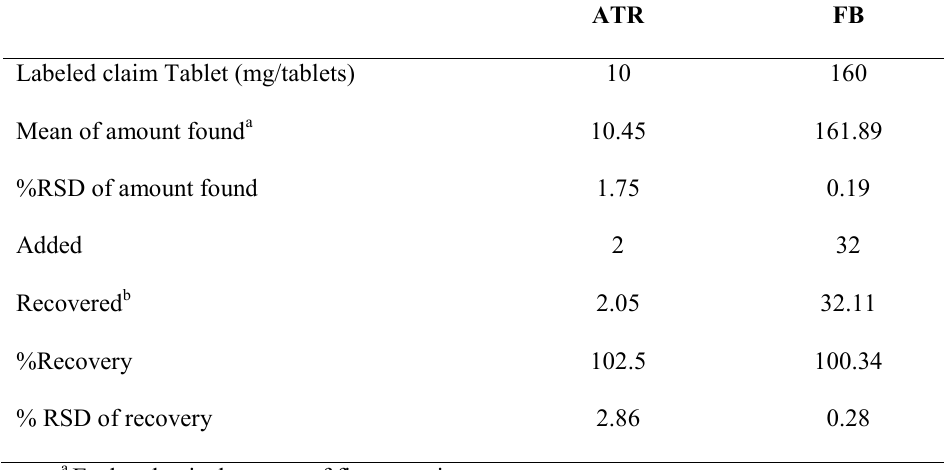
Table 4 : Results of the assay and the recovery analysis of ATR and FB in tablet